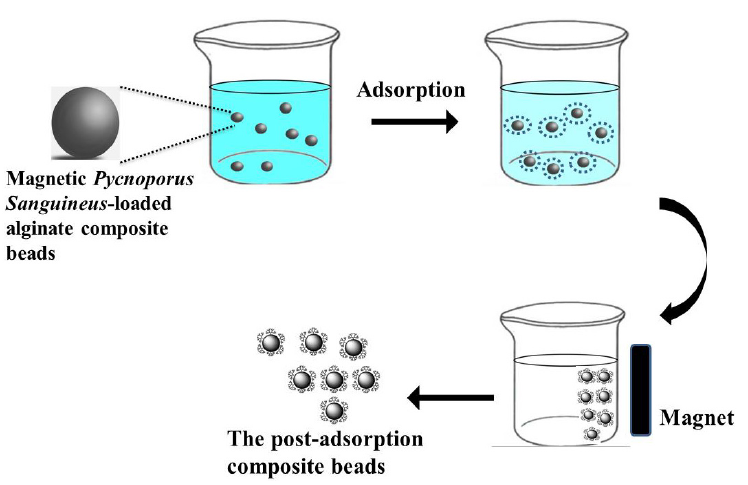
Figure 1. Schematic diagram of the adsorption and magnetic separation